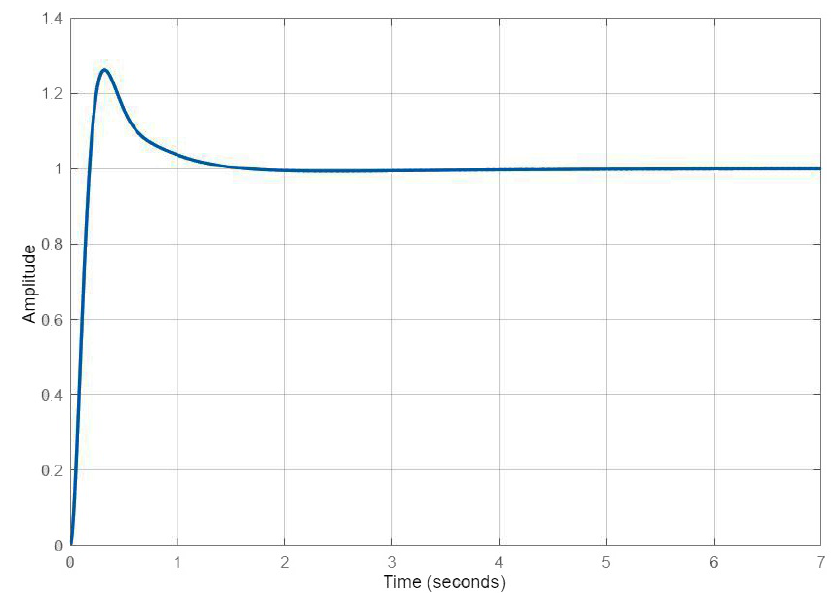
Figure 4. Altitude response to the first control law.